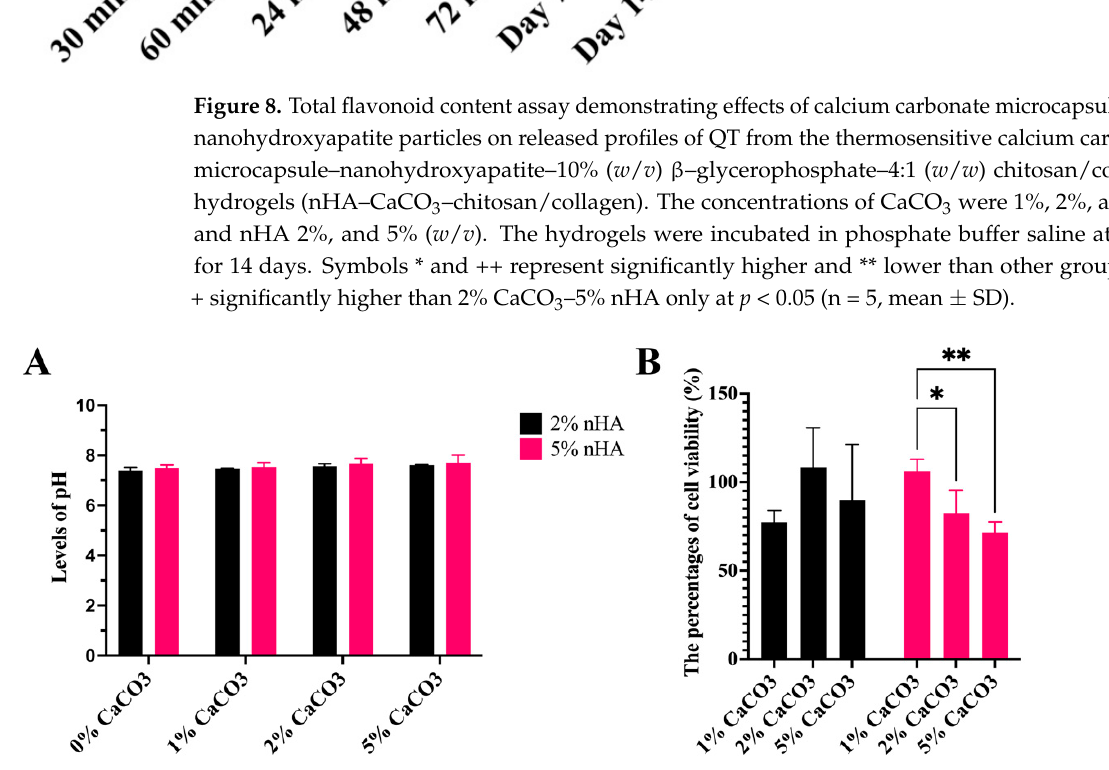
Figure 9. Effects of calcium carbonate microcapsules on acid–base balance (pH) and cell cytotoxicity of the thermosensitive calcium carbonate microcapsule–nanohydroxyapatite–10% ( w / v ) β -glycerophosphate–4:1 ( w / w ) chitosan/collagen (CaCO 3 –nHA–chitosan/collagen) hydrogels. The concentrations of CaCO 3 were 1%, 2%, and 5%, and those of nHA were 2% and 5% ( w / v ). ( A ) Levels of pH and ( B ) percentages of cell viability derived from cell viability assay. The symbols * and ** represent significantly different values with p < 0.05 and p < 0.01 (n = 5, mean ± SD).